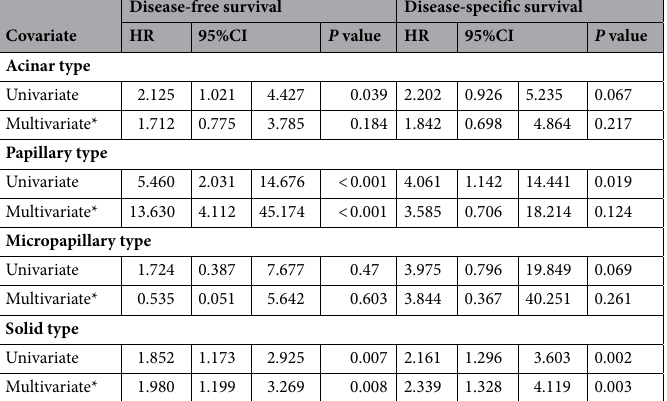
Table 1. Univariate and multivariate analyses of disease-free survival and disease-specific survival based on cancer-associated fibroblasts. *Adjusted for T stage, N stage, age, sex and smoking